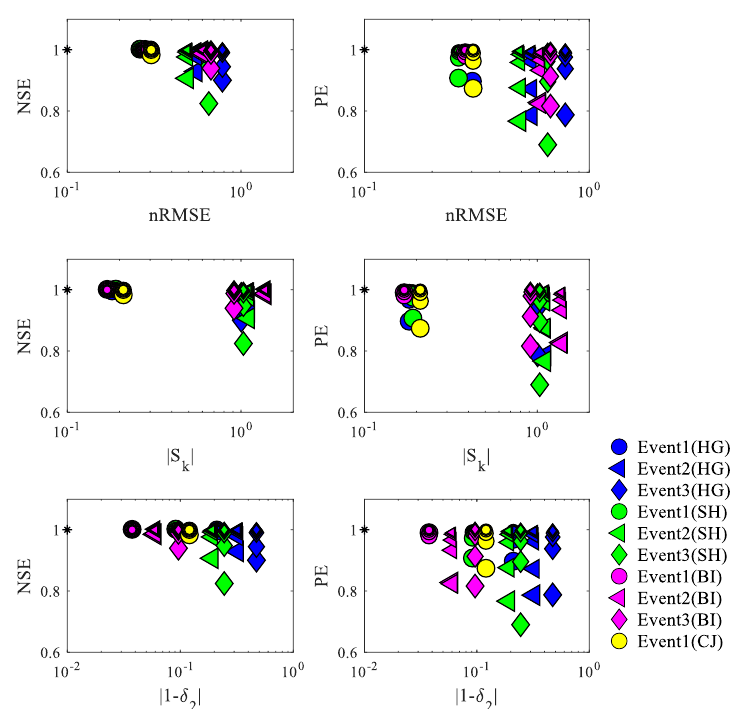
Figure9. RelationshipbetweenvariationofNSEandPEby L r , andnRMSE, S k , and δ 2 (with T r = 10min). Figure 9. Relationship between variation of NSE and PE by 𝐿 𝑟 , and nRMSE, 𝑆 𝑘 , and 𝛿 2 (with 𝑇 𝑟 = Symbol size is proportional to the L r from 250 m to 16 km. 10 min ). Symbol size is proportional to the 𝐿 𝑟 from 250 m to 16 km.